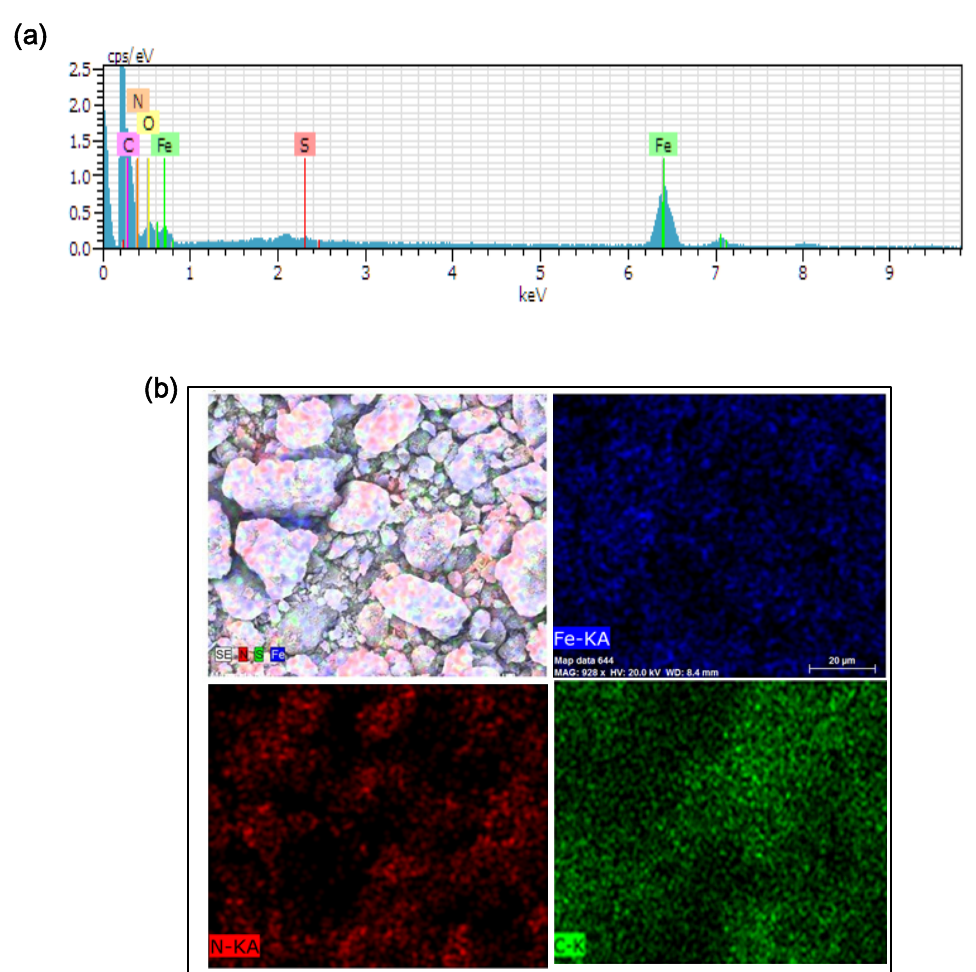
Figure 6. EDS ( a ) spectrum ( b ) Fe, N, and C mapping of FeNC(OA) .